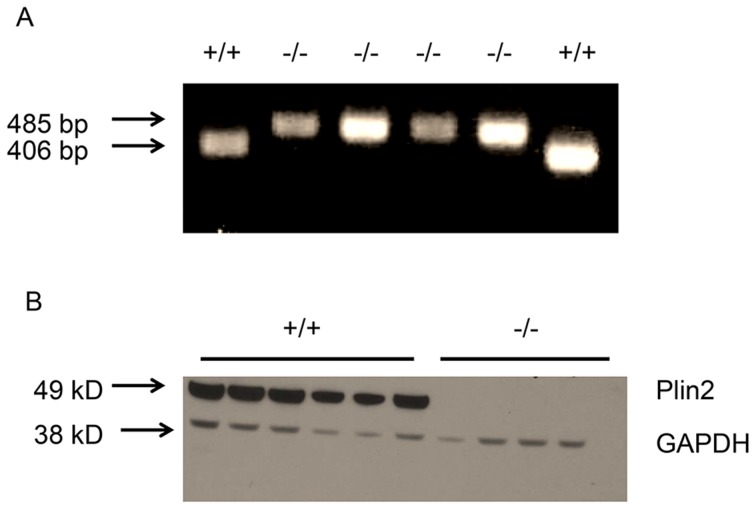
Confirmation of plin2ko mice.A) Genotyping of wildtype +/+ and Plin2KO (−/−) mice using tail DNA. Bands correspond to 485 BP KO PCR product and 406 bp WT PCR product. B) Immunoblots of Plin2 and GAPDH from liver lysates of wildtype and Plin2KO mice. Each lane represents liver lysate from an individual mouse. Plin2 = Perilipin 2 GAPDH =  glycerol-3-phosphate dehydrogenase housekeeping protein.